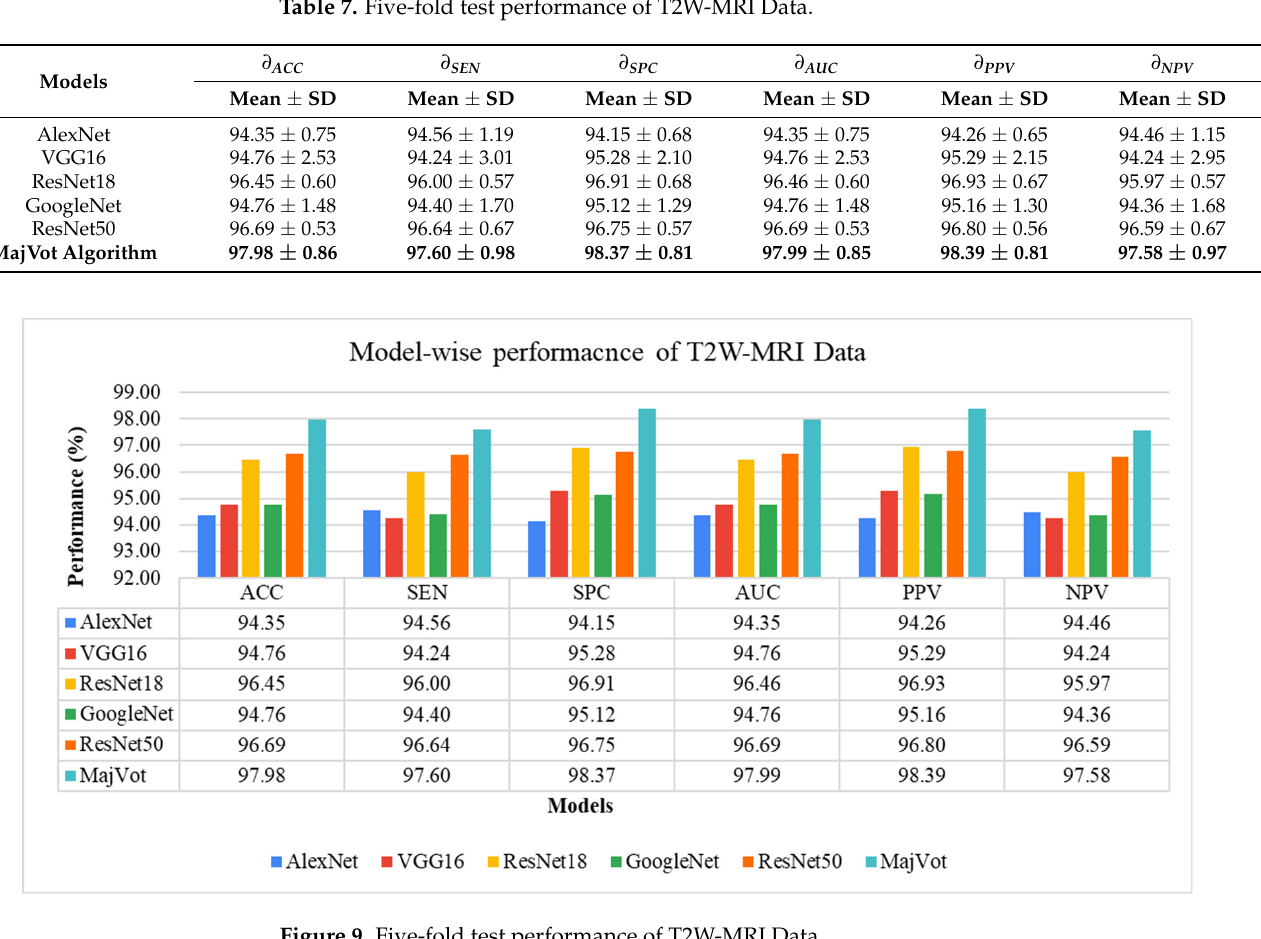
Figure 10. Model-wise accuracy behavior in the five-fold test performance of T2W-MRI data.